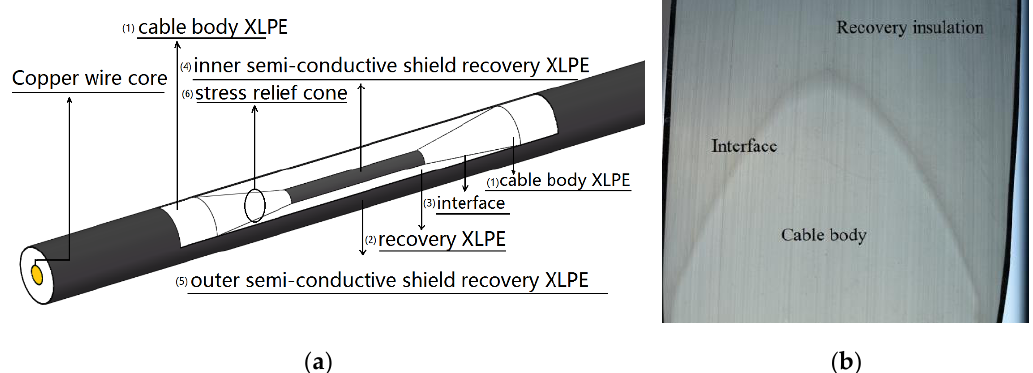
Figure 1. ( a ) Schematic factory joint of high voltage submarine cable from which the ( b ) slice samples of EMJ are produced.